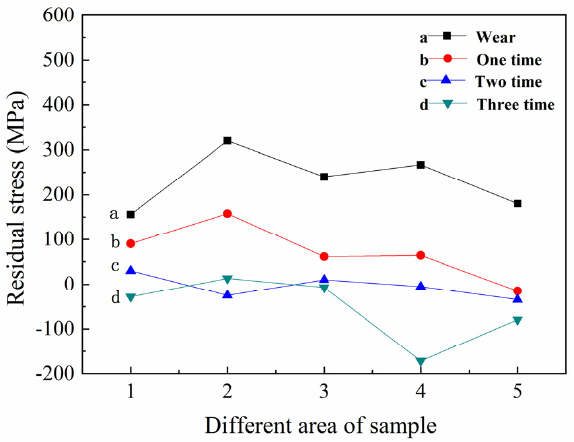
Figure 9. Residual stress distribution of the 316L stainless steel samples along the vertical weld seam after different numbers-of peening.